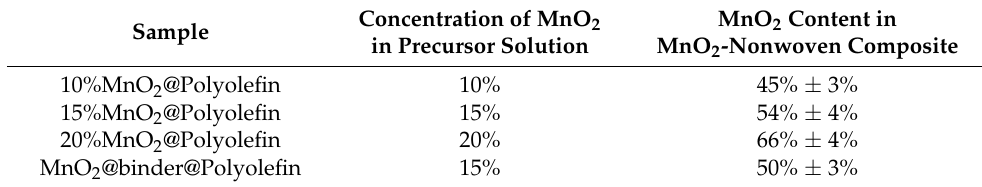
Figure 1. Technological production process of MnO 2 -nonwoven composite filters. Table 1. Preparation details in MnO 2 -nonwoven composites.